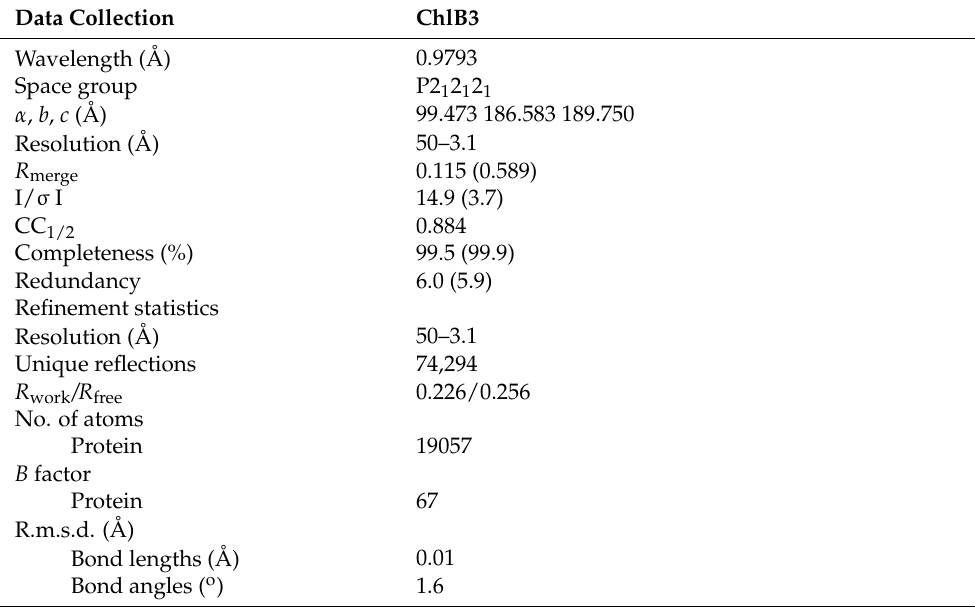
Table 1. Crystallographic data collection and refinement statistics. Parentheses indicate values for the shell with the highest